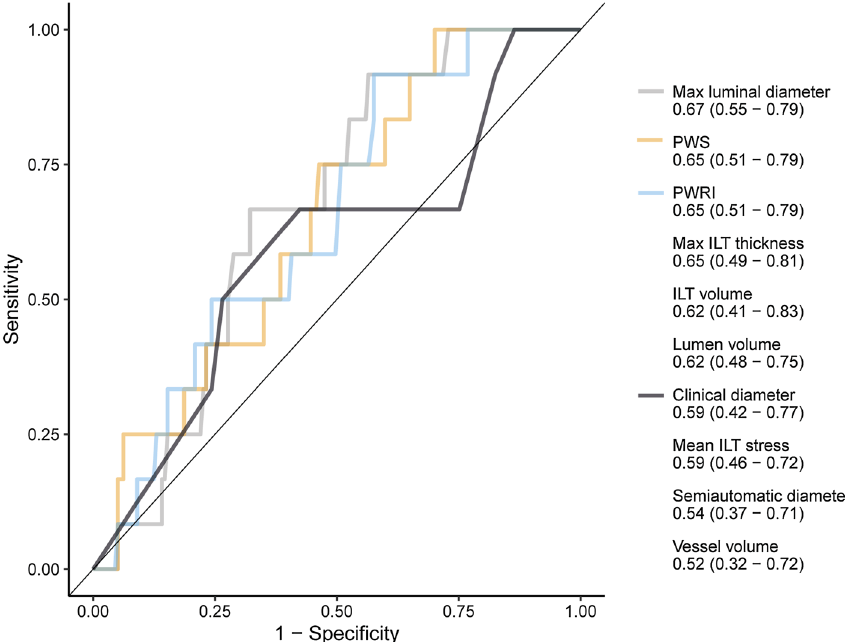
Figure 4. Receiver operating characteristic curves for the prediction of future rupture or symptomatic aneurysm. The area under curve (95% confidence interval) is presented below each variable. Only significant curves and the clinical diameter reference are displayed. Abbreviations ; ILT: intraluminal thrombus, PWRI: peak wall rupture index, PWS: peak wall stress, WS: wall